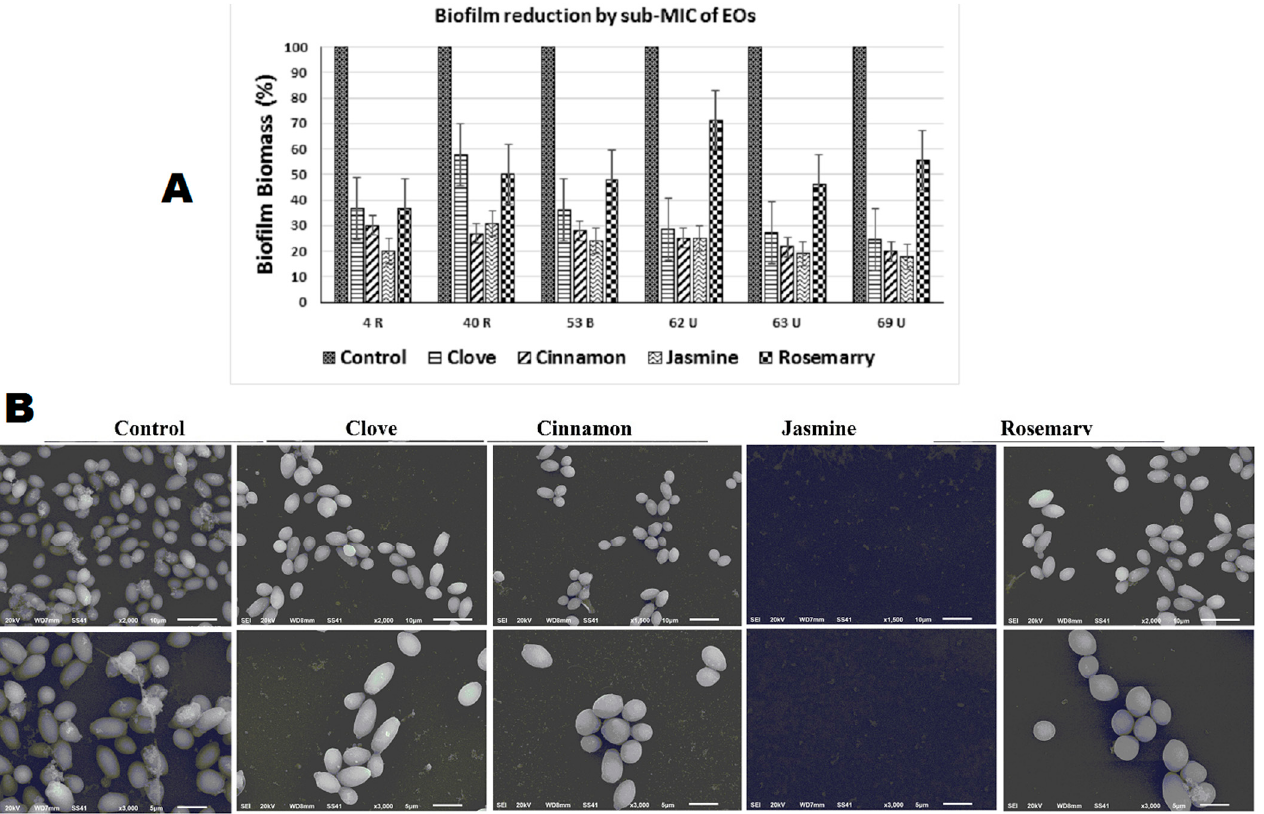
Figure 2. Assessment of biofilm and adhesion inhibition in clinical C. albicans isolates in absence (control) and presence of sub-MIC of cinnamon, clove, jasmine and rosemary oils, using ( A ) crystal violet assay of biofilm biomass showing significant reduction in absorbance upon exposure to essential oils (EOs). ( B ) SEM images of control C. albicans and those exposed to EOs, scale bars are 10 µm in upper panel and 5 µm in lower panel. Table 3. Inhibition of C. albicans phospholipase, hemolysin and biofilm formation using sub-inhib- itory concentration (¼ MIC) of different EOs.